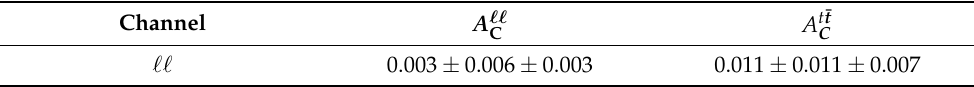
Table 4. Results for the lepton-based asymmetry A (cid:96)(cid:96) for detector, resolution, and acceptance effects. The values are presented with their statistical and systematic uncertainties [44].